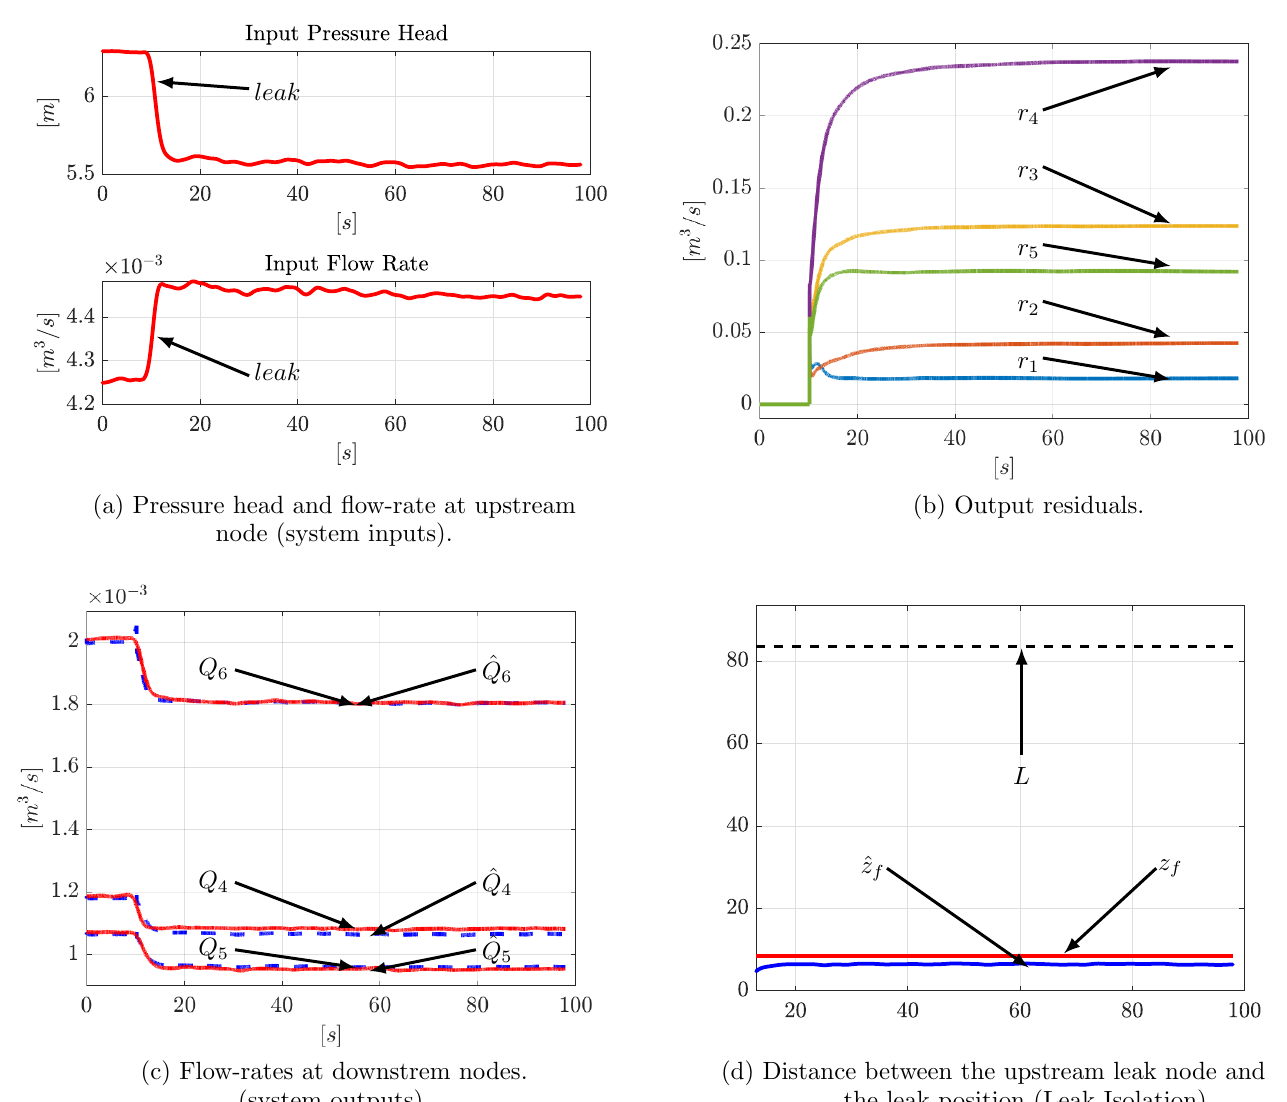
Figure 12. Experiment 1: leak induced in valve 1: ( a ) Pressure head and flow rate at upstream, ( b ) Output residuals, ( c ) Flow rate at downstream nodes and, ( d ) Leak